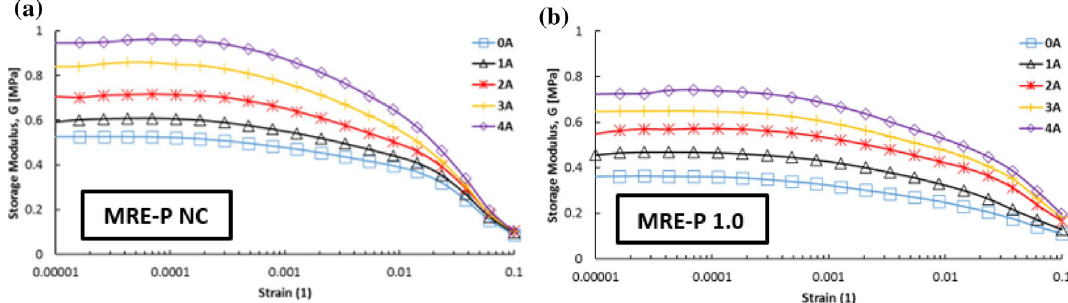
Figure 5. Dependence of storage modulus of MREs towards applied strains containing plate-like CIPs with selected corrosion rate ( a ) 0 and ( b ) 1.0 vol.%